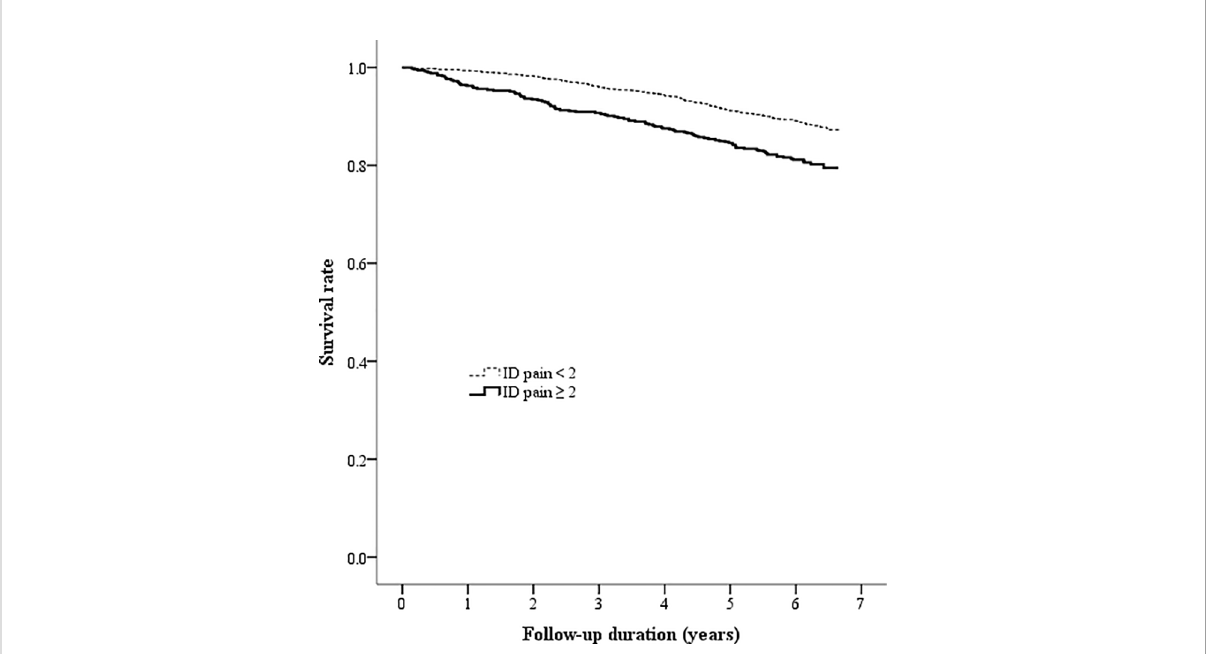
FIGURE 2 Kaplan-Meier curves showing the survival rate between the two patient groups categorized by the baseline ID pain score (ID pain = identi fi cation pain